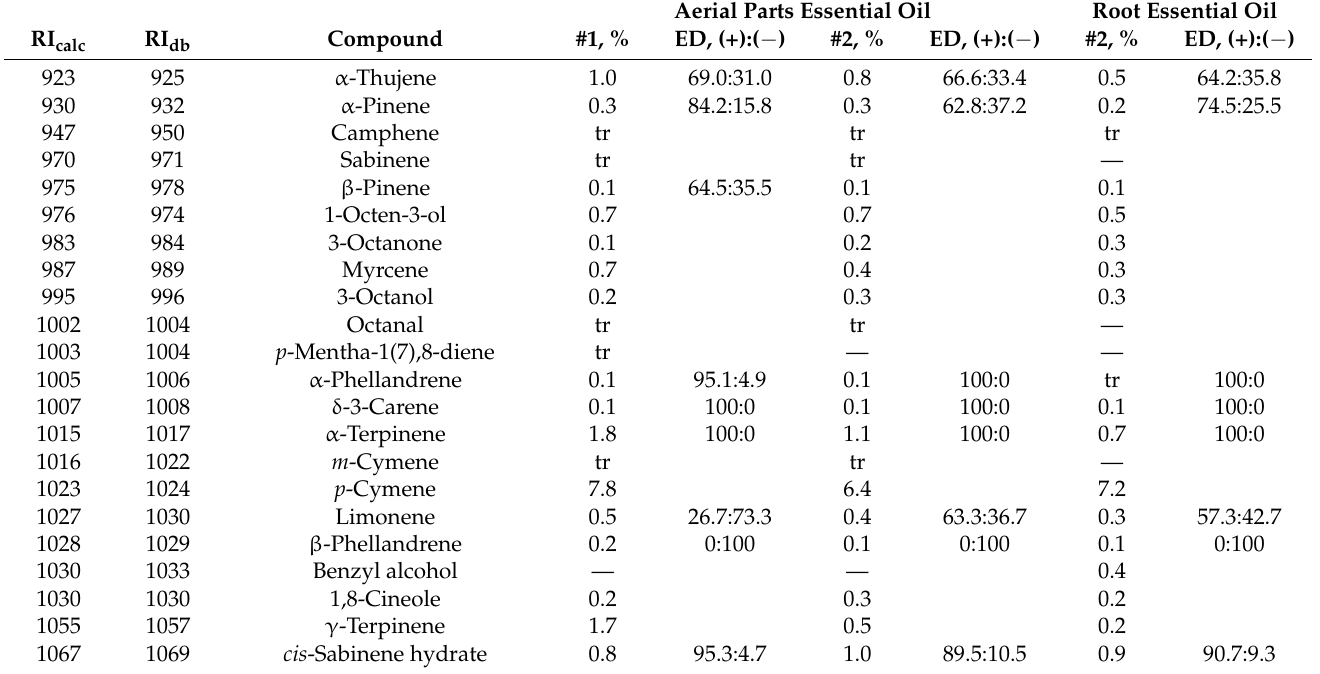
Table 1. Essential oil compositions of Monarda citriodora cultivated in south Alabama.